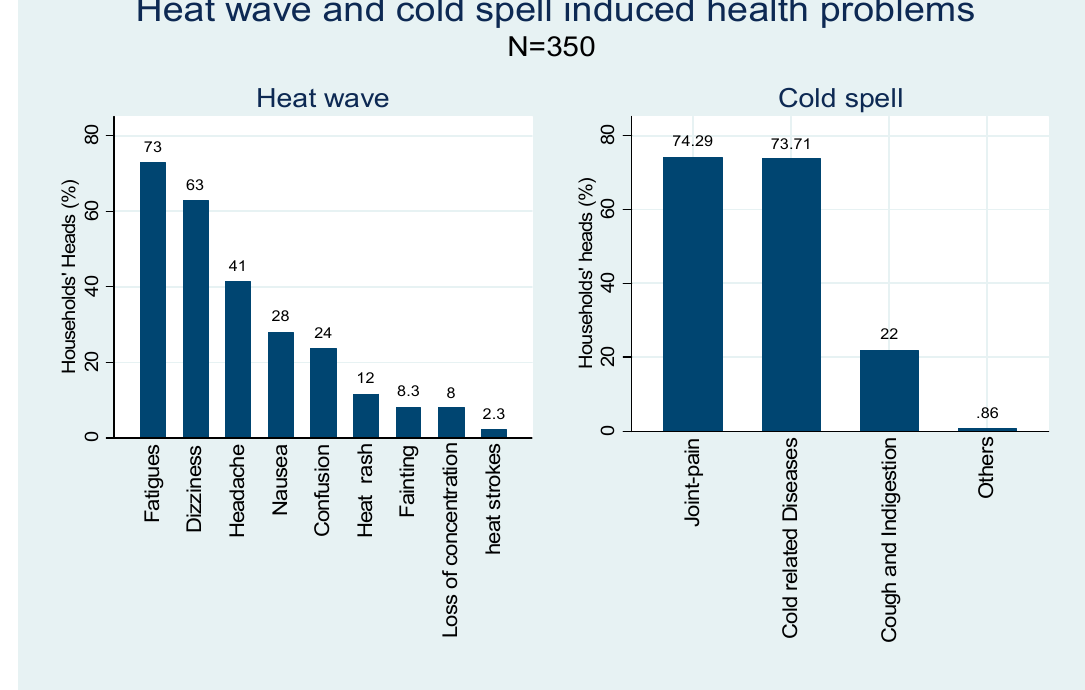
Figure 3. Heat wave and cold spell induced health problems.